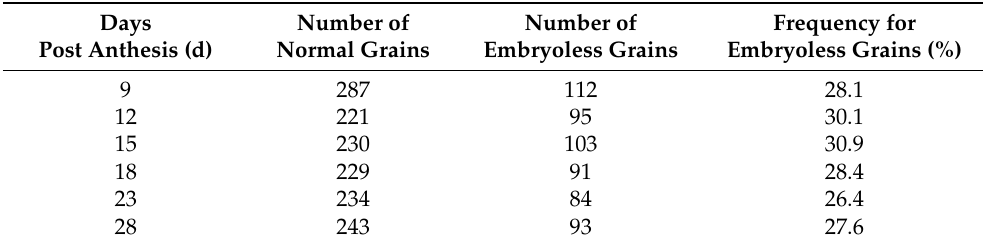
Table 4. Dynamic change of embryo lethality during wheat grain filling period in the triple mtl - ABD